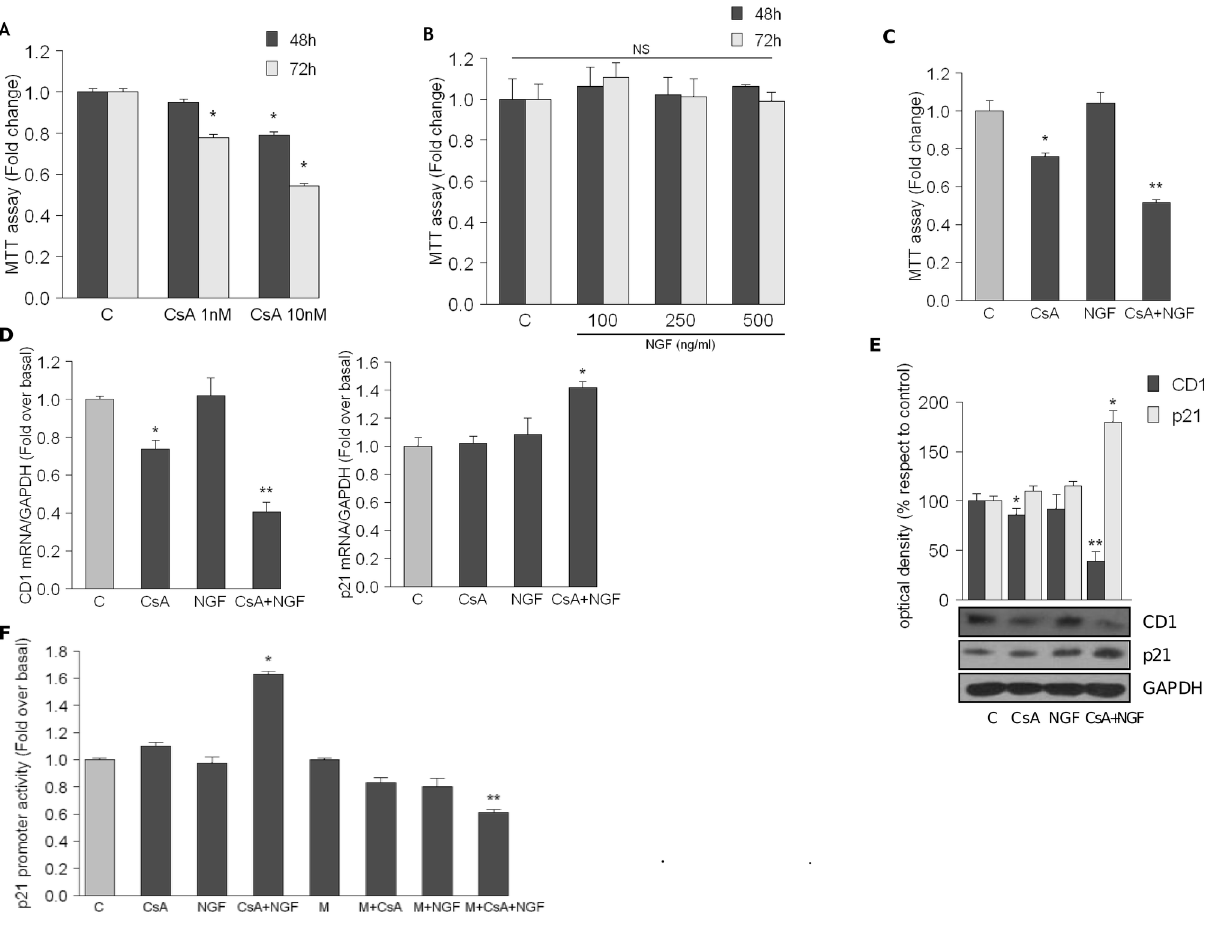
Figure 2. Combined treatment with CsA plus NGF inhibits cell growth inducing p21 promoter activity. (A) MTT growth assays in HK-2 cells untreated (c) or treated with CsA (1–10nM) (A) or NGF (100–250–500ng/ml) (B). Cell proliferation is expressed as fold change respect to control. *p<0.05 vs c ; NS: not significant. (C) MTT growth assay in HK-2 cells untreated (c) or treated with CsA 10nM, NGF 100 ng/ml, alone or in combination for 48h. Results are expressed as fold change respect to c. *p<0.05 compared with c. **p<0.05 compared with CsA-treated cells. (D) CD1 and p21 mRNA content, evaluated by real time RT-PCR after 24 hours of exposure to CsA 10nM and NGF 100ng/ml alone or in combination. Each sample was normalized to its GAPDH mRNA content. *p<0.05 compared with c; **p<0.05 compared with CsA-treated cells. (E) HK-2 cells were untreated (c) or treated for 24h with CsA 10nM and NGF 100ng/ml alone or in combination. CD1 (Antibody dilution 1:500) and p21 (1:500) protein levels were determined by WB. β-Actin (1:10000) was used as loading control. Immunoblots show a single representative of 3 separate experiments. The upper panels represent the means ± SD of 3 separate experiments between CD1/β-Actin and p21/β-Actin levels in which band intensities were evaluated in terms of optical density arbitrary units and expressed as percentages of the control (100%). *p<0.05; **p<0.05 compared with CsA-treated cells. (F) HK-2 cells, transiently transfected with p21 promoter, were untreated (c) or treated for 15h with CsA 10nM, NGF 100ng/ml, Mithramycin (M) 100nM alone or in combination and then luciferase activity was measured. Luciferase activity of untreated cells was set as 1-fold induction, upon which treatments were calculated. *p<0.05 compared with c; **p<0.05 compared with cells CsA+NGF-treated. Bars represent the means ± SD of 3 different experiments each performed in triplicate. Secondary antibodies dilutions used are: goat anti-mouse (1:2000) or anti-rabbit (1:7000).